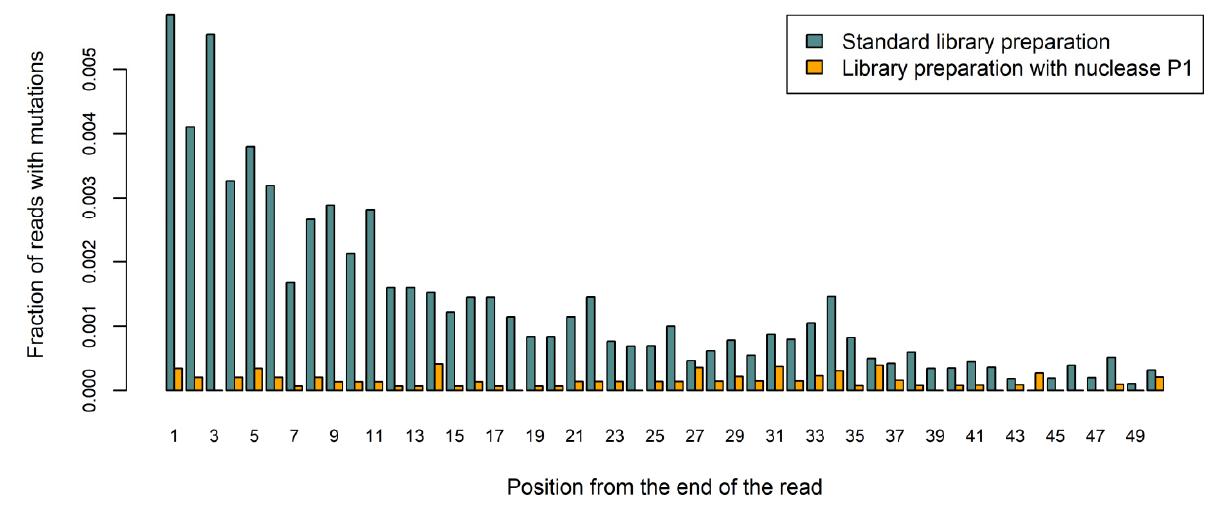
Figure 3. A higher number of duplex sequencing-supported mutations occurs toward the ends of DNA fragments in libraries prepared with a common approach, which utilizes DNA polymerase to blunt-end DNA, but not in libraries prepared with the nuclease P1-based method. NGS libraries were prepared from five colorectal carcinoma FFPE-derived DNA samples, and aggregated data are shown in the figure. Positions from 1 to 50 from either end of each DNA fragment were ana- lyzed.